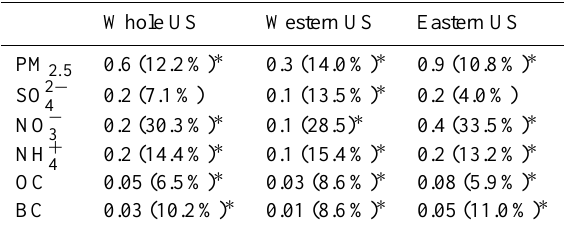
Table 2. The absolute (µgm − 3 ) and relative (%) differences in simulated aerosol concentrations between the PNA + and PNA − months (PNA + minus PNA − ). The simulated concentrations are averaged over the whole of US, the western US (west of 100 ◦ W), or the eastern US (east of 100 ◦ W). The concentrations are from the GEOS-Chem simulation for 1986–2006. Whole US Western